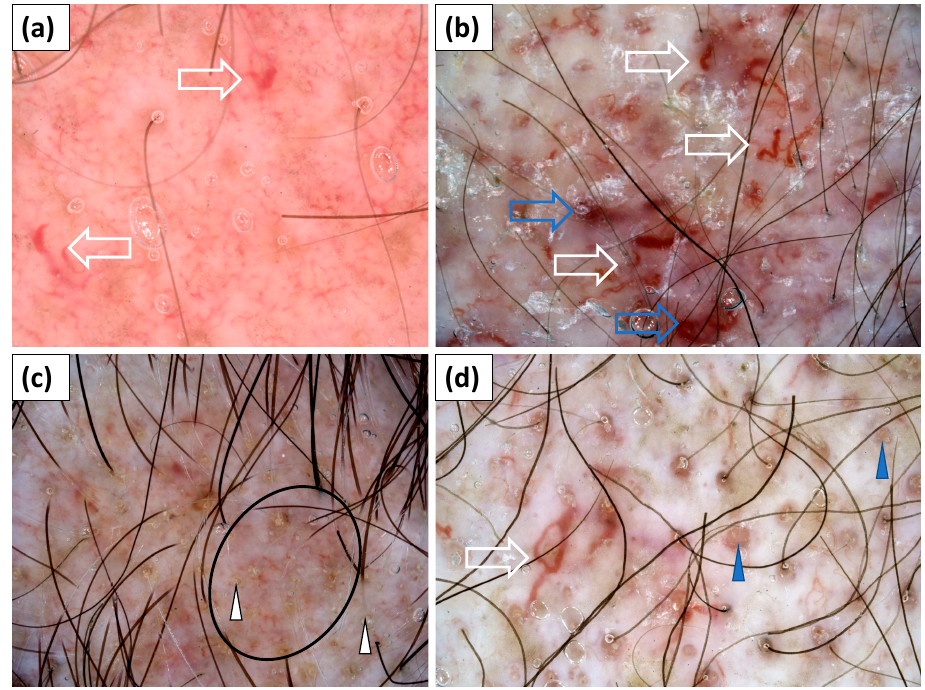
Figure 2. ( a – d ) Trichoscopy showed yellow dots (white arrowhead); red follicular dots (blue arrowhead); interfollicular honeycomb pigment pattern (black circle); thick linear, linear branched, and linear curved capillaries (white arrow); and lake-like structures (blue arrow) .